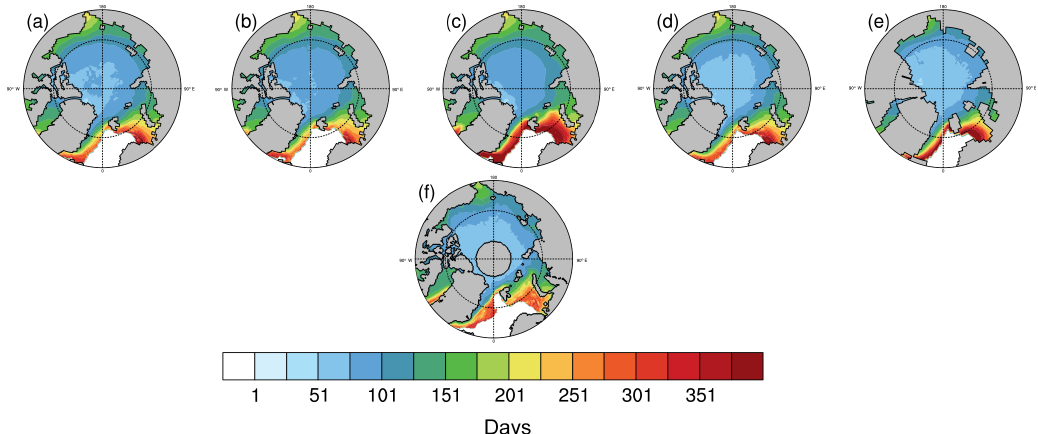
Figure 5. Average melt season lengths over 1979–2014, for each CESM LE definition using ensemble member 35: (a) congelation–snowmelt, (b) frazil–snowmelt, (c) volume–volume, (d) temperature–snowmelt, (e) temperature–temperature and (f) PMW satellite observations. Plots from ensemble member 34 are very similar and shown in Fig.